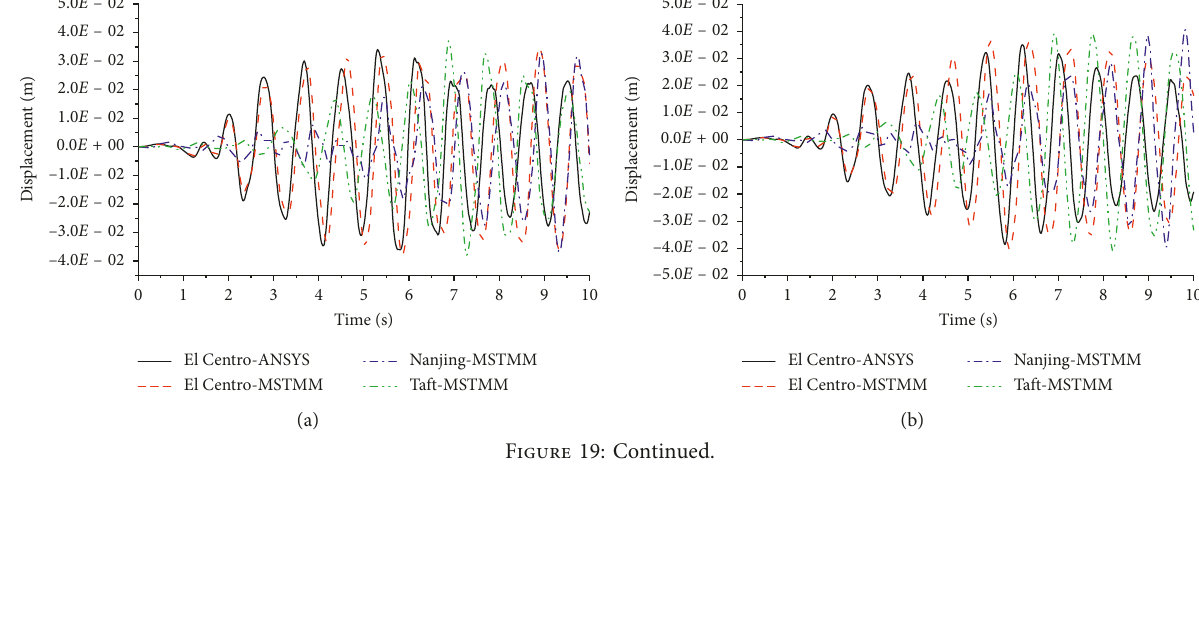
a 1 , 15 displacement under seismic wave (peak acceleration is 400 cm/s